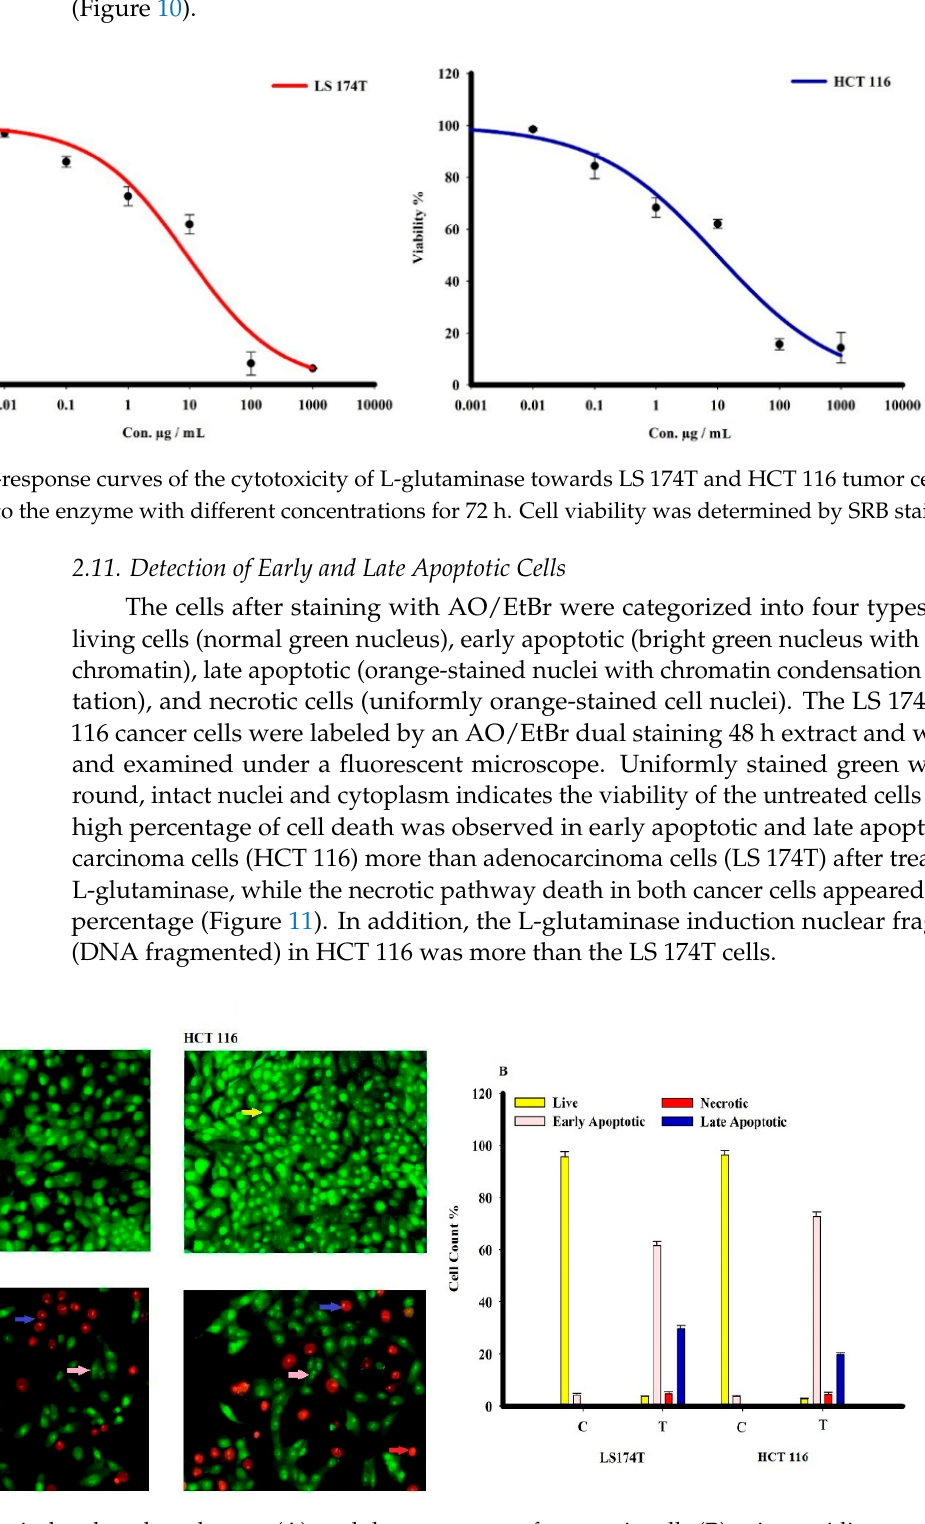
Figure 11. Morphological and nuclear changes ( A ), and the percentage of apoptotic cells ( B ) using acridine orange and ethidium bromide staining evaluated by the effect of L-glutaminase treatment on apoptosis of LS 174T and HCT 116 human tumor cells after 48 h treatment induced various nuclear and chromatin changes (fragmentation and condensation) at 200 × . Yellow arrows indicate live cells, pink arrows indicate early apoptotic, red arrows indicate necrotic, and blue arrows indicate late apoptotic